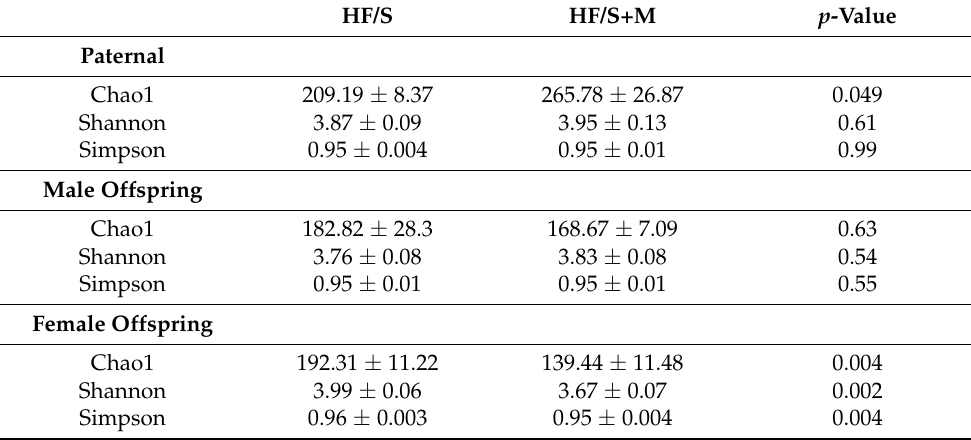
Table 4. Alpha diversity for fathers and offspring at 9 weeks of